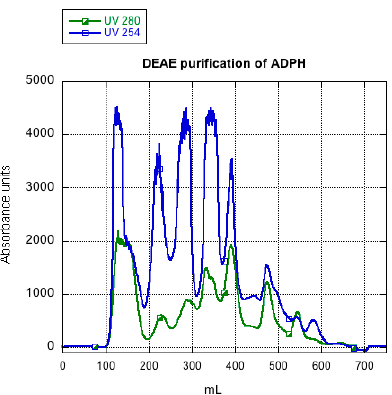
Figure 4. Trace from the AKTA purifier of DEAE purification of crude ADPH.